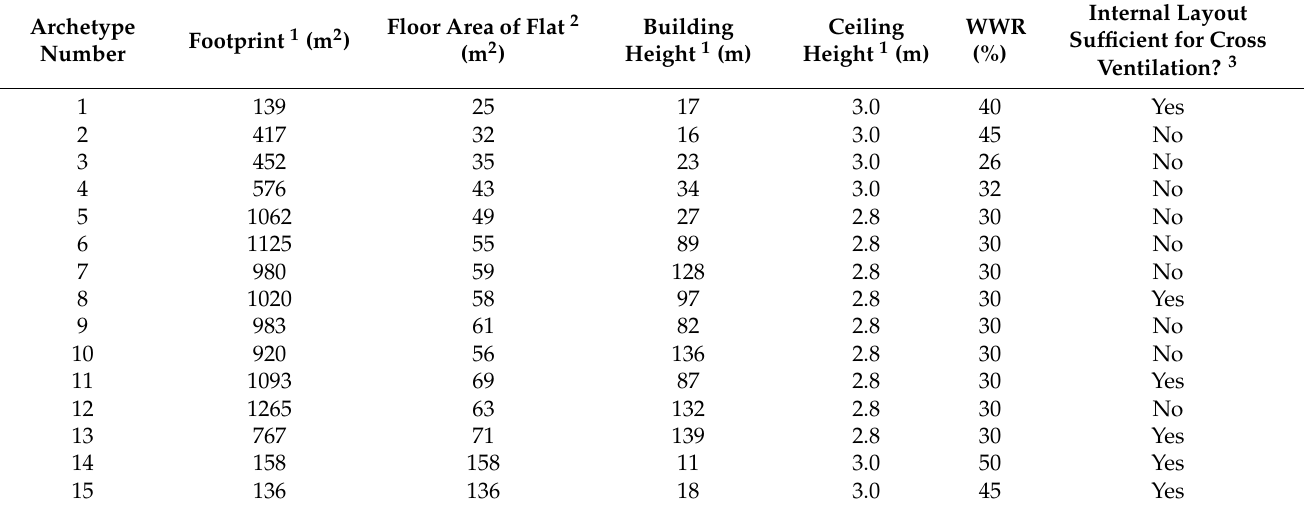
Table 2. Geometrical characteristics of the 15